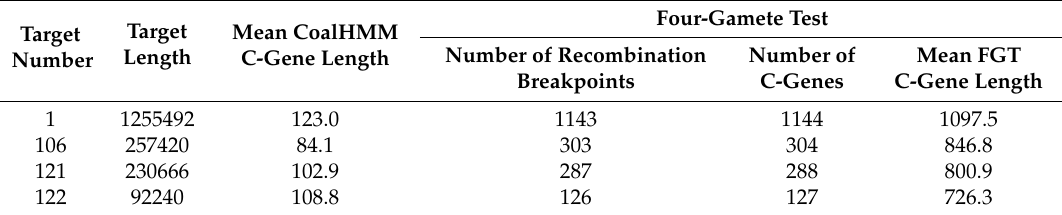
Table 1. Comparison of the number of recombination breakpoints and coalescence genes (c-genes) based on CoalHMM and the four-gamete test (FGT) for four target regions from Hobolth et al.